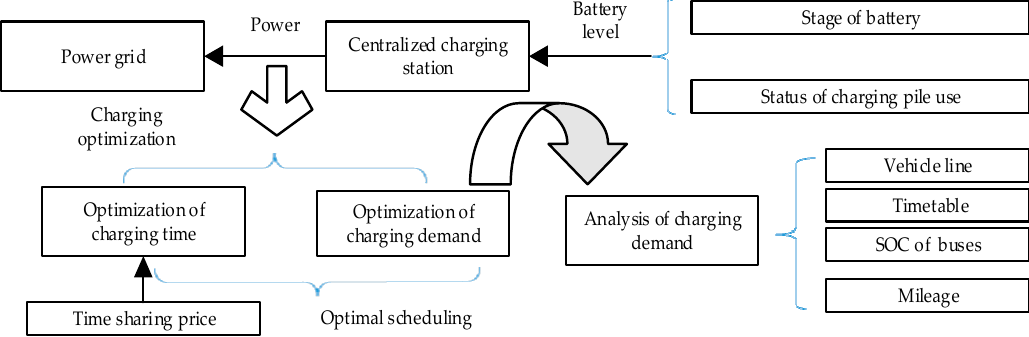
Figure 3. Scheduling operation of charging station.